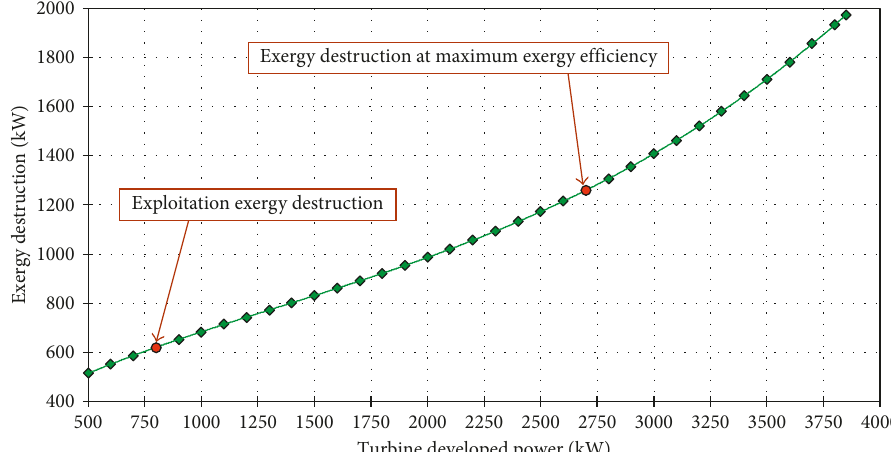
Figure 4: Steam turbine exergy destruction change during the developed power variation—operating point 3.